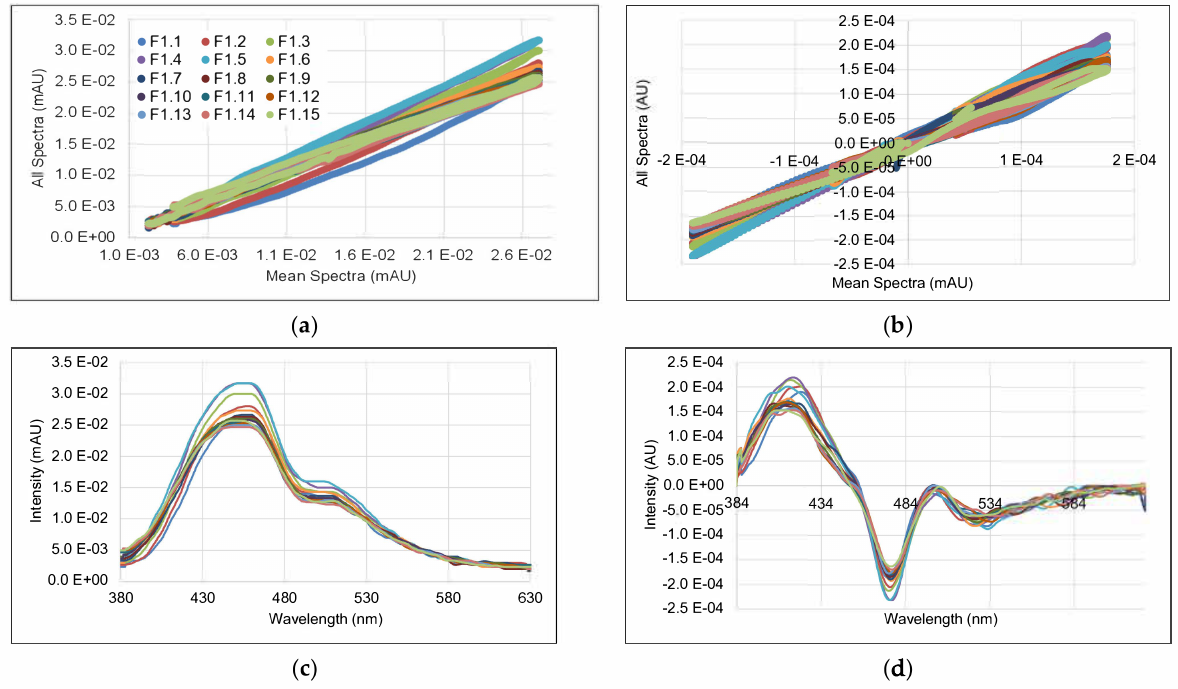
Figure 9. ( a ) Scatter effects of fluorescence spectra before and ( b ) after preprocessing; ( c ) data of fluorescence spectra before and ( d ) after preprocessing, legend from ( a ) applies for all